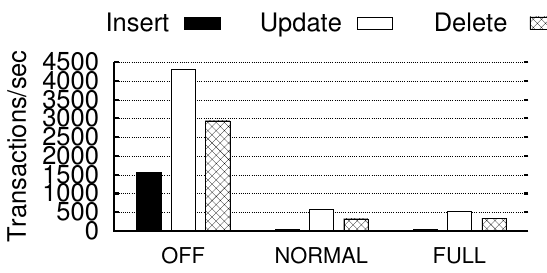
Figure 12. SQLite operation with various sync mode on internal eMMC. Journal mode: DELETE [Samsung Galaxy S4, Android 4.2.2 (JB), /data partition, EXT4].